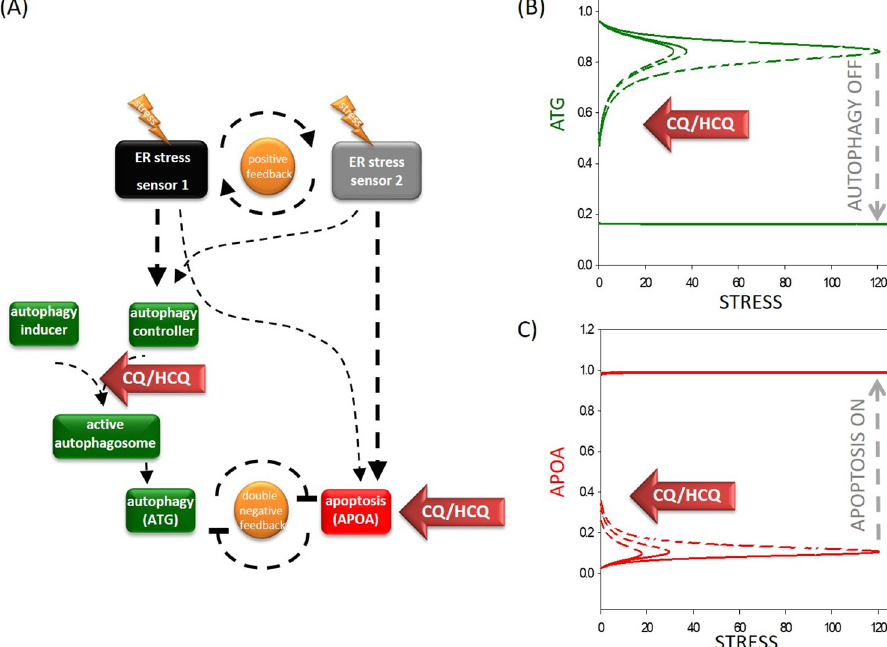
Fig 2. The simple network of autophagy-dependent survival upon chloroquine treatment during cellular stress. (A) The wiring diagram of the response mechanism . The active form of the ER stress sensor 1 and 2, autophagy inducer, autophagy controller, active autophagosome, ATG and APOA are grouped together in isolated coloured boxes. ATG represents the active form of autophagy activator complex, while APOA represents the active form of apoptosis. Dashed lines show how the molecules can influence each other. Blocked end lines denote inhibition. Red arrows labelled with “chloroquine” show where the drug treatment affects the control network, while yellow “thunders” symbolize the cellular stress. The signal-response curves of (B) survival process and (C) cell death process are shown with respect to increasing stress level . On the “x” axis the stress level, while on the “y” axis the relative activity of (B) ATG or (C) APOA are plotted. Solid lines denote stable state, while dashed line denotes the unstable state of the control network at a given stress level. Grey dashed arrows depict the threshold for autophagy inactivation / cell death activation. Red arrows labelled with “chloroquine” show how the signal-response curves are changing according to increasing level of chloroquine (for the code, see S1 File).